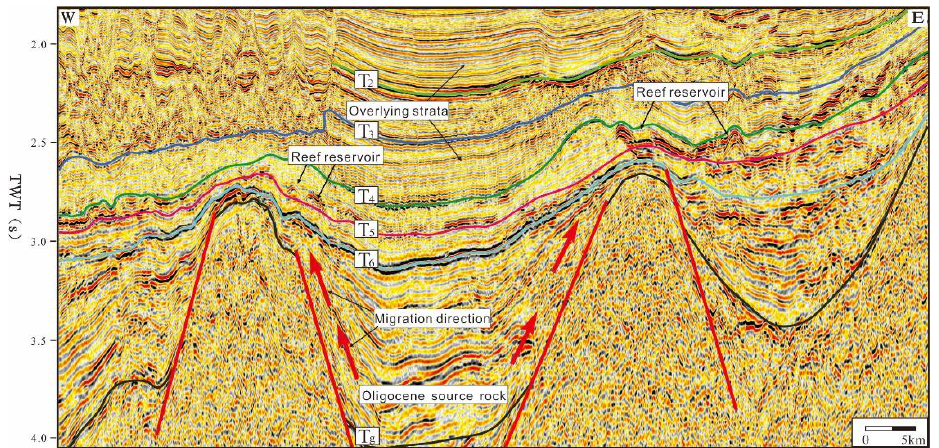
Figure 12. Hydrocarbon accumulation process of the reef and carbonate platform in the western Xisha sea area. The profile location is shown in Figure 1B.